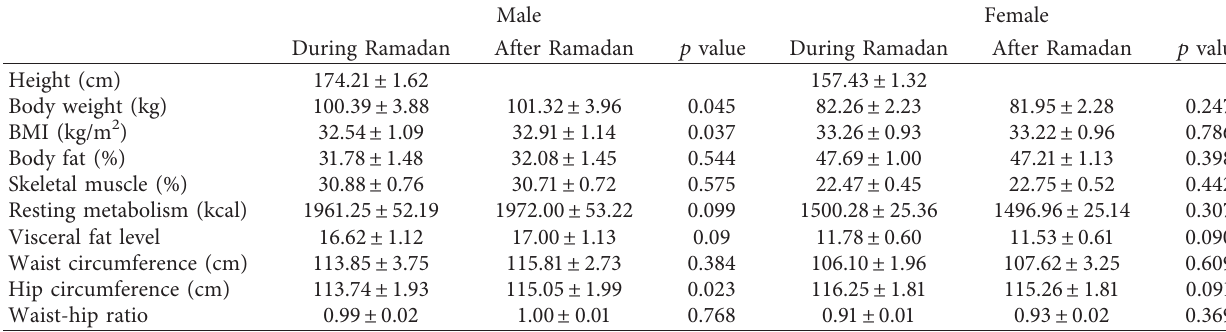
Table 2: Anthropometric measurements during and after Ramadan.